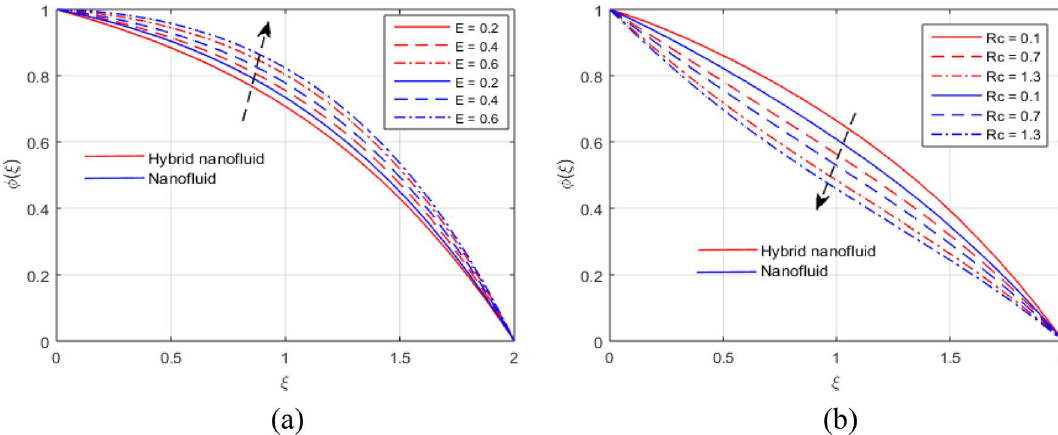
Figure 14. ( a , b ) Effect of E and Rc on φ(ξ) .